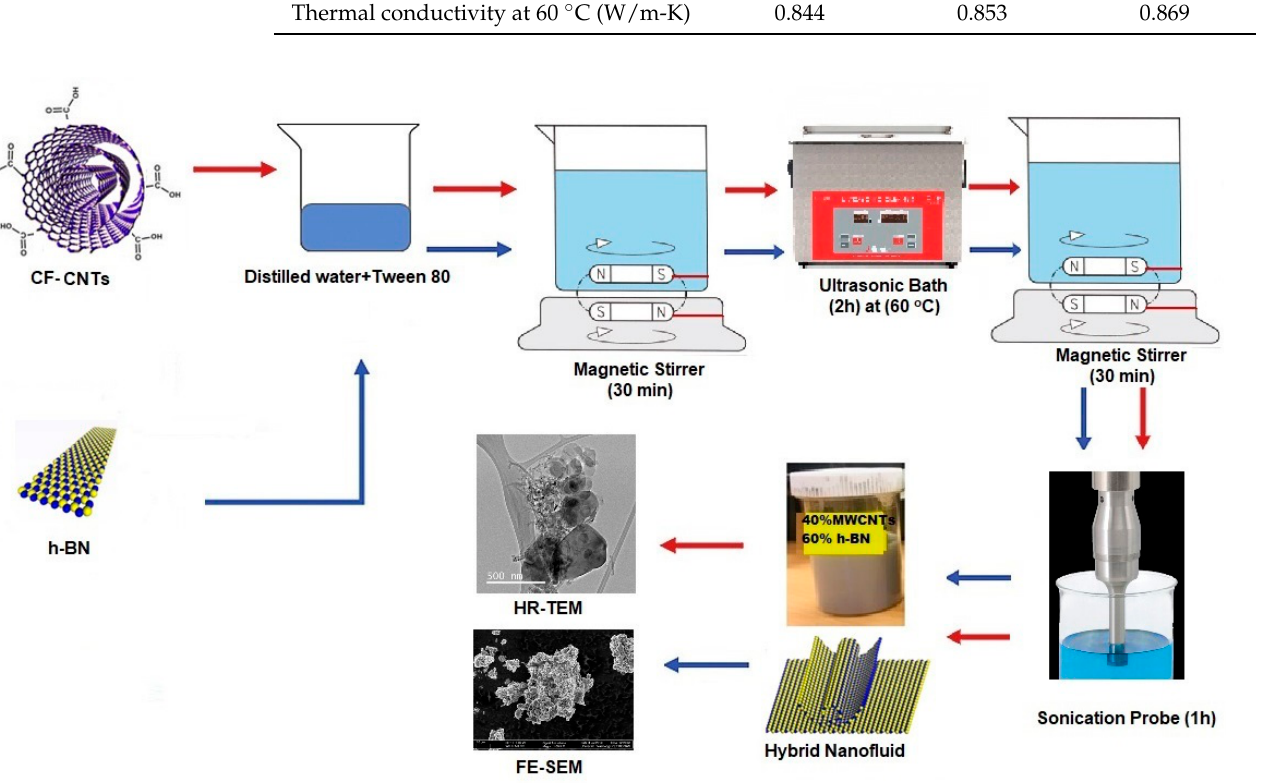
Figure 1. Photograph of the CF-CNTs and hBN nanocomposite mixture and preparation of the the nanofluid. Table 1. Details of the samples with different ratios of hybrid nanofluid following preparation.